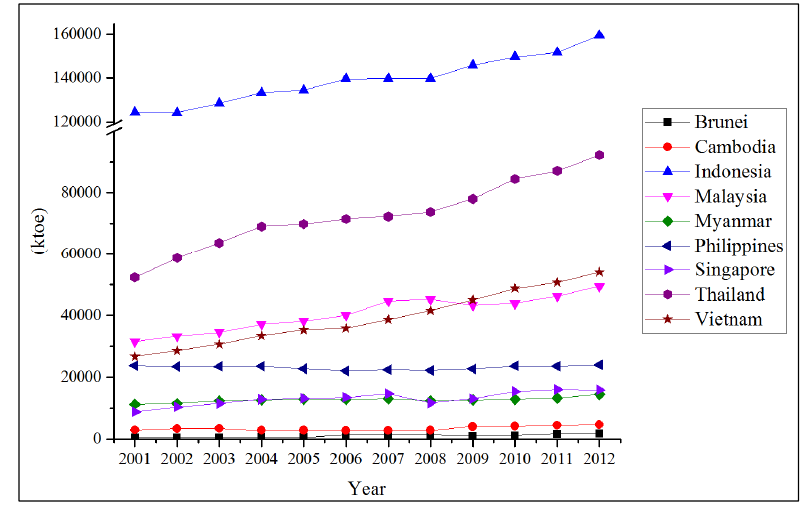
Figure 21. ASEAN final energy